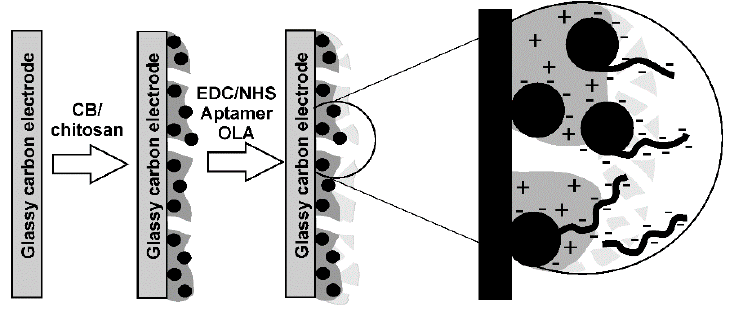
Figure 2. Outline scheme of the aptasensor